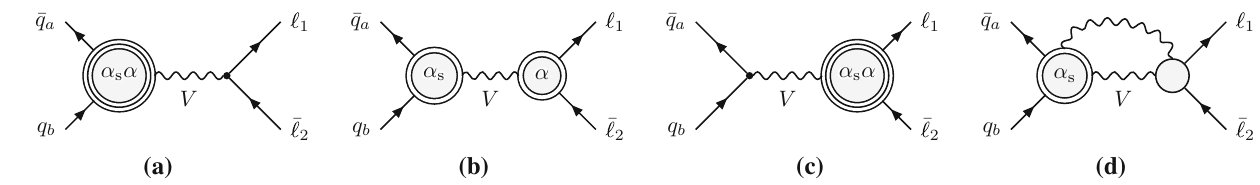
Fig. 35 Generic diagrams for the various contributions to the virtual factorizable ( a – c ) and non-factorizable ( d ) corrections of O (αα s ) in PA, with α α , and αα s , s in the blobs indicating the order of the included loop